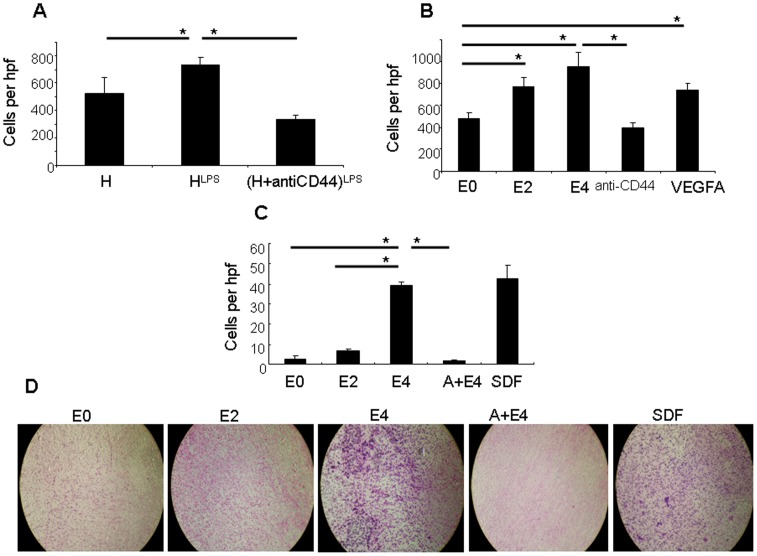
Increased ECFC adhesion and migration following incubation with E-selectin.
A) ECFC adhesion to fibronectin following exposure to conditioned media from control HUVEC cells (H), from injured HUVEC cells (HLPS), and from LPS-treated HUVECs with the addition of anti-CD62E (H+anti-CD62E)LPS and shown as cells per high powered field (hpf) (* p<0.05). B) Adhesion of ECFCs to fibronectin following 2 hour incubation with E-selectin at 2 µg/ml (E2) or 4 µg/ml (E4) compared to controls (0 µg/ml, E0), in the presence of anti-CD44 and E-selectin (4 µg/ml) and VEGF-A 100 ng/ml (VEGFA). (* p<0.05). C) Migration of ECFCs towards E-selectin in the lower chamber at 2 µg/ml (E2) or 4 µg/ml (E4) compared with controls containing no E-selectin in the lower chamber (E0) or when ECFCs were incubated in the presence of anti-CD44 with E-selectin 4 µg/ml in the lower chamber (A+E4), and to SDF-1a (100 ng/ml) in the lower chamber (SDF). (* p<0.05). D) Photgraphs of the underside of porous membranes used in the migration assays described in part C.